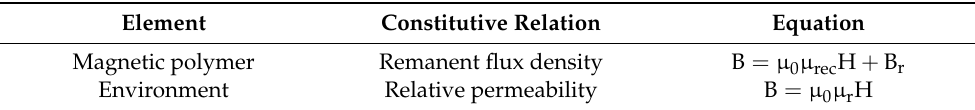
Table 2. Constitutive relations used in the second part of the model. Element Constitutive Relation Equation Magnetic